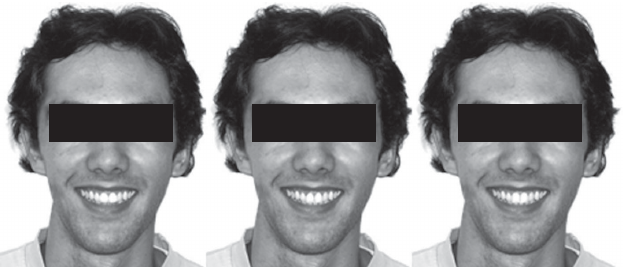
Fig.4 - Male tapered facial contour set. Each photograph presents a different shape of upper central incisors.